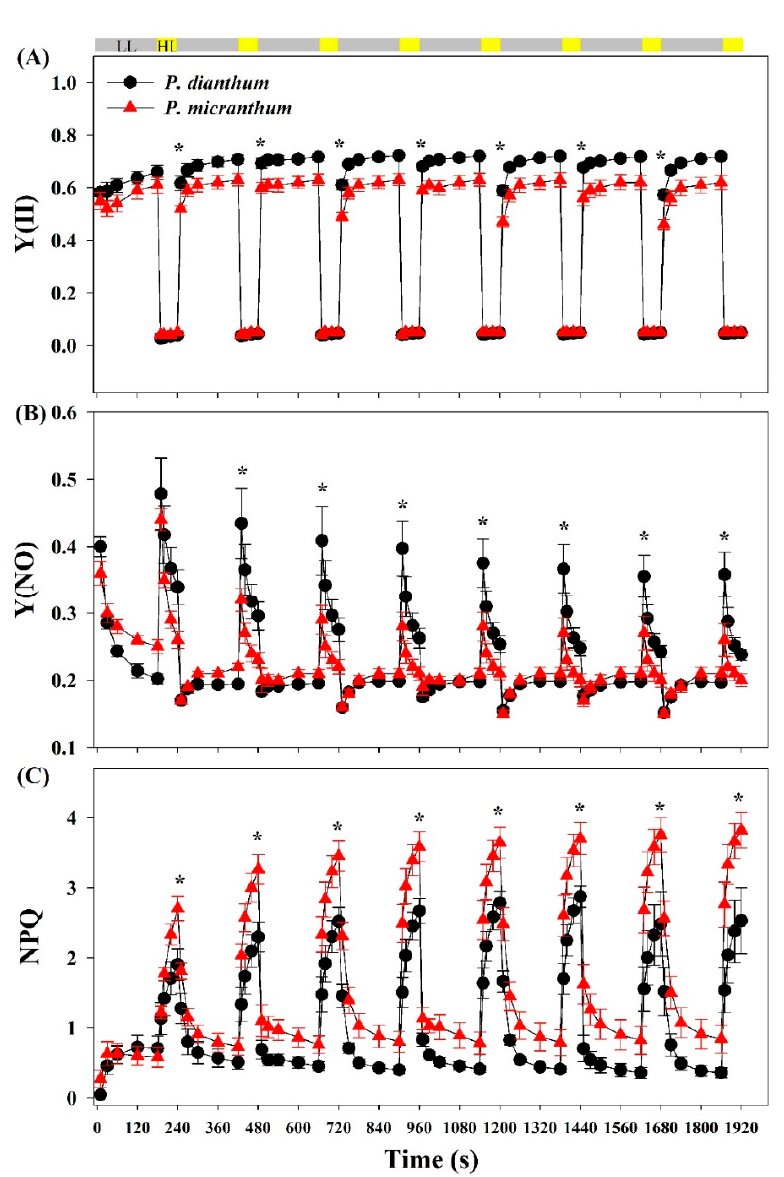
Figure 2. PSII parameters of Paphiopedilum dianthum and P. micranthum under fluctuating light. Y(II), effective quantum yield of photosystem II ( A ); Y(NO), quantum yield of non-regulated energy dissipation in PSII ( B ); NPQ, non-photochemical quenching ( C ). Each data point represents the mean ± SE for five measurements from five individual plants. LL, low light; HL, high light. Asterisks indicate significant differences between P. dianthum and P. micranthum with the t-tests of independent